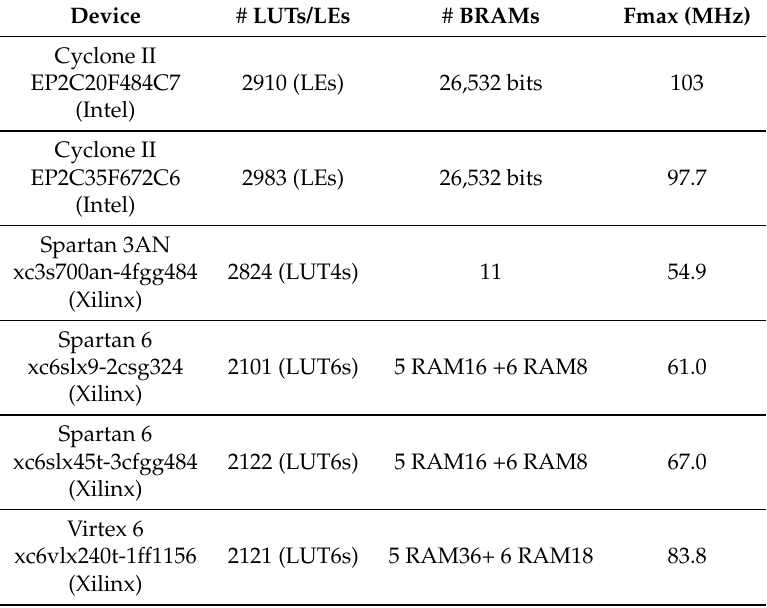
Table 4. Area and delay figures for ECC163AES128 core implementation on different